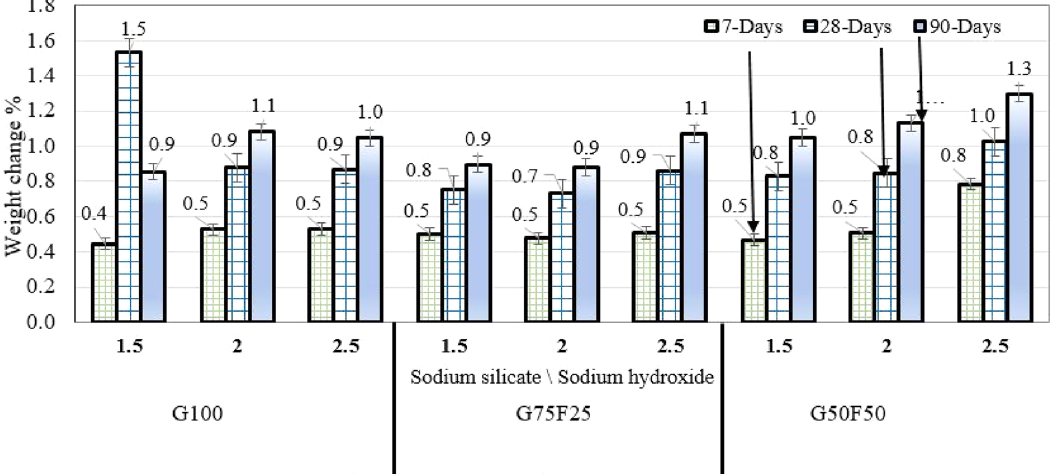
Figure 1. Weight change of G100, G75F25, and G50F50 mortar samples due to immersion in 10% sulfuric acid